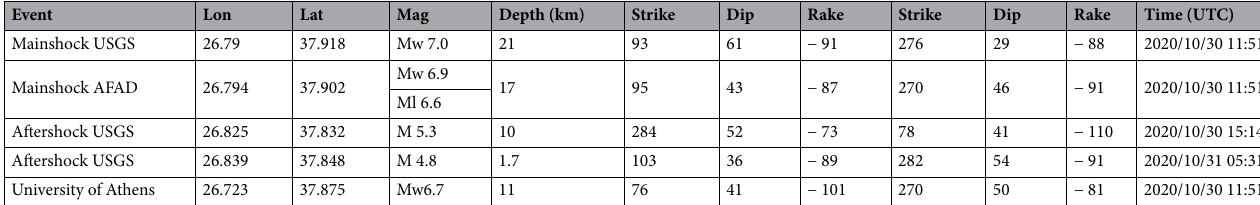
Table 1. Focal mechanism solutions for the major shock and aftershocks. Sources of data: USGS (https:// earth quake. usgs. gov/ earth quakes/ event page/ us700 0c7y0/ execu tive), AFAD (Disaster and Emergency Management of Turkey) (https:// www. afad. gov. tr/ izmir- sefer ihisar- depre mi- duyuru- 79- 16112 020--- 1800), University of Athens (http:// www. geoph ysics. geol. uoa. gr/ stati ons/ gmaps3/ event page_ leaf. php? scid= nkua2 020vi mx& lng= en).